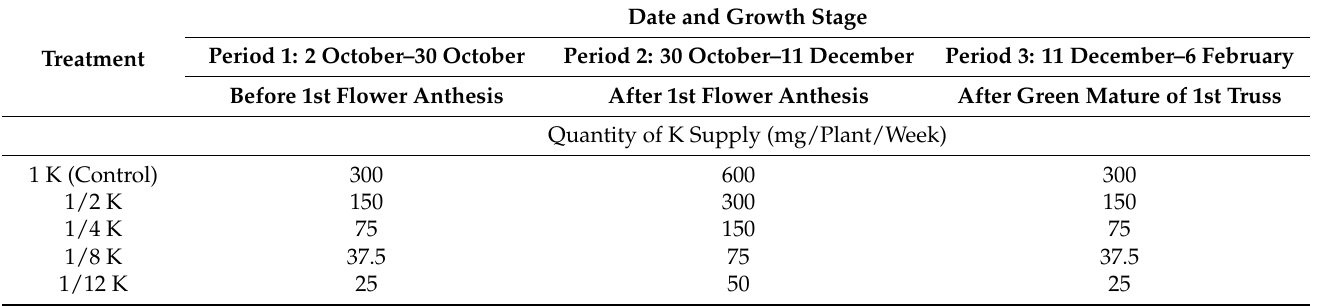
Table 1. Fertilization design of each